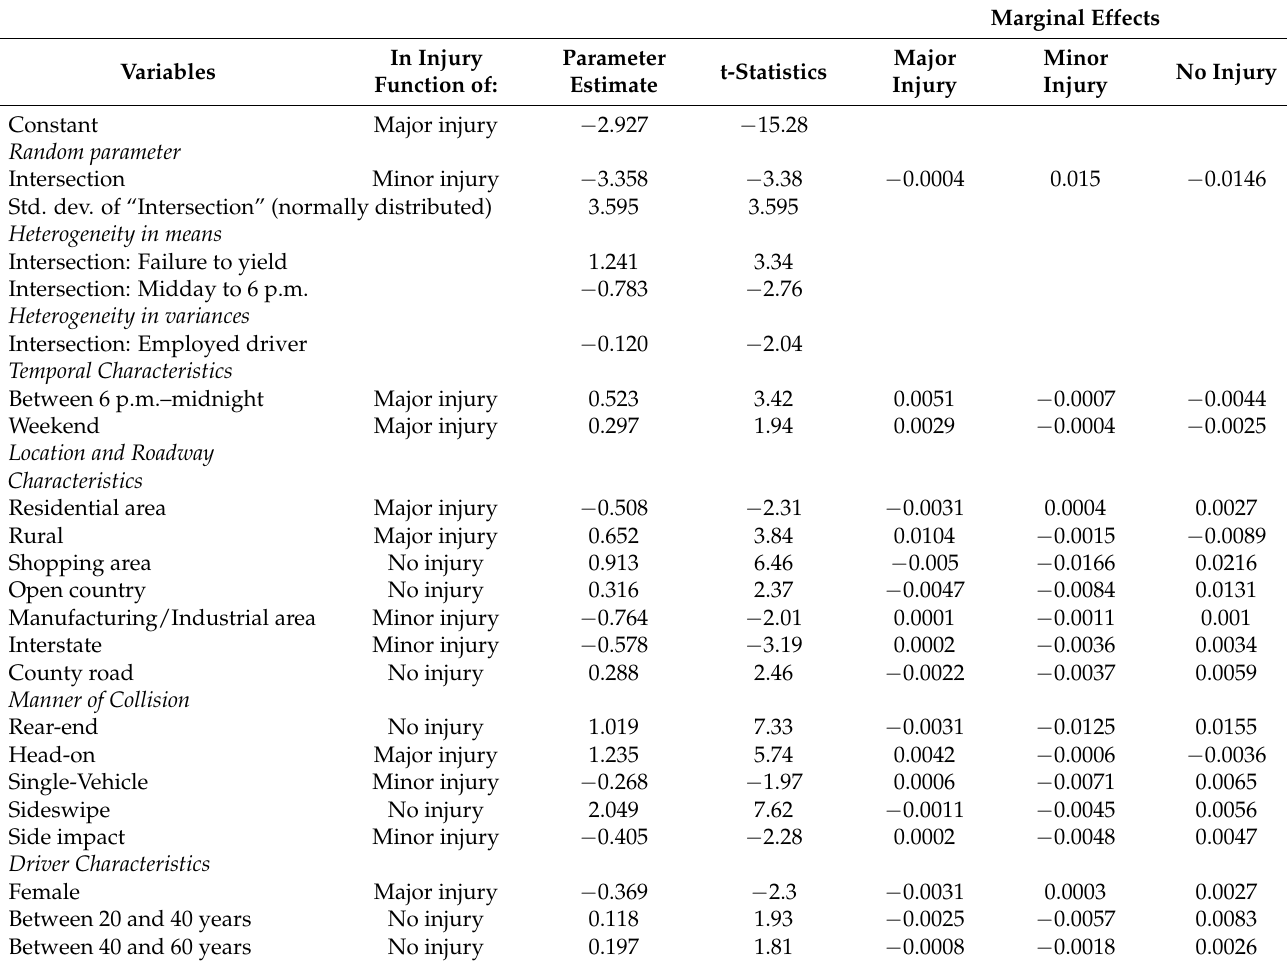
Table 4. Severity model results and averaged marginal effects during shelter-in-place